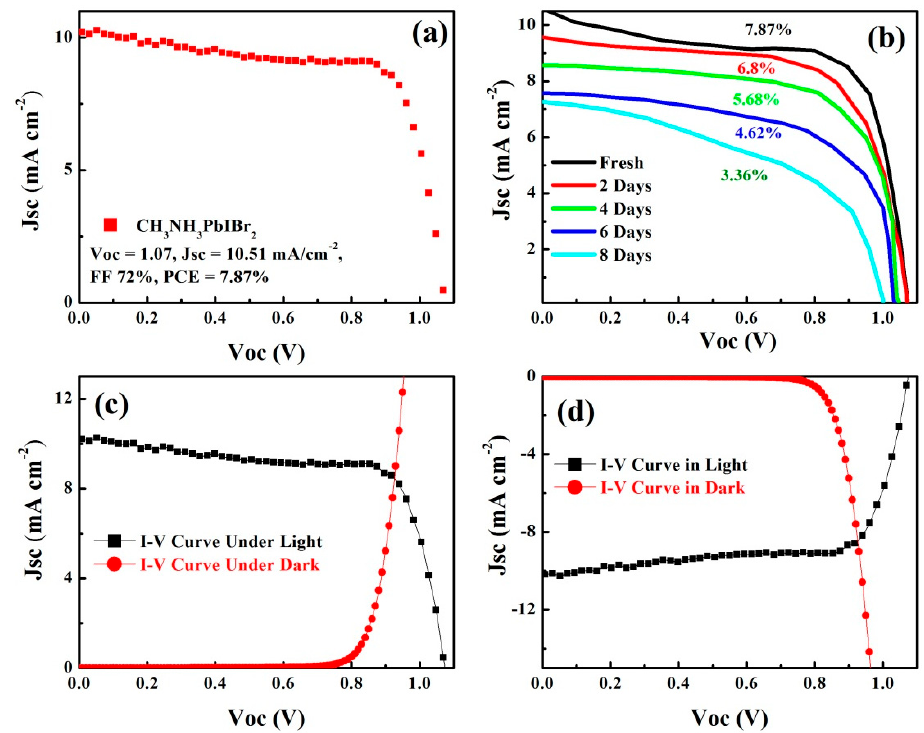
Figure 8. ( a ) Characteristic current–voltage (J-V) curve for photovoltaic cell based on CH 3 NH 3 PbIBr 2 layer and its PV performance measured under AM 1.5G condition, ( b ) the stability (J-V curves) of perovskite solar cell based on CH 3 NH 3 PbIBr 2 absorber material for 8 days, ( c , d ) the J-V curve behaviors in light and dark.